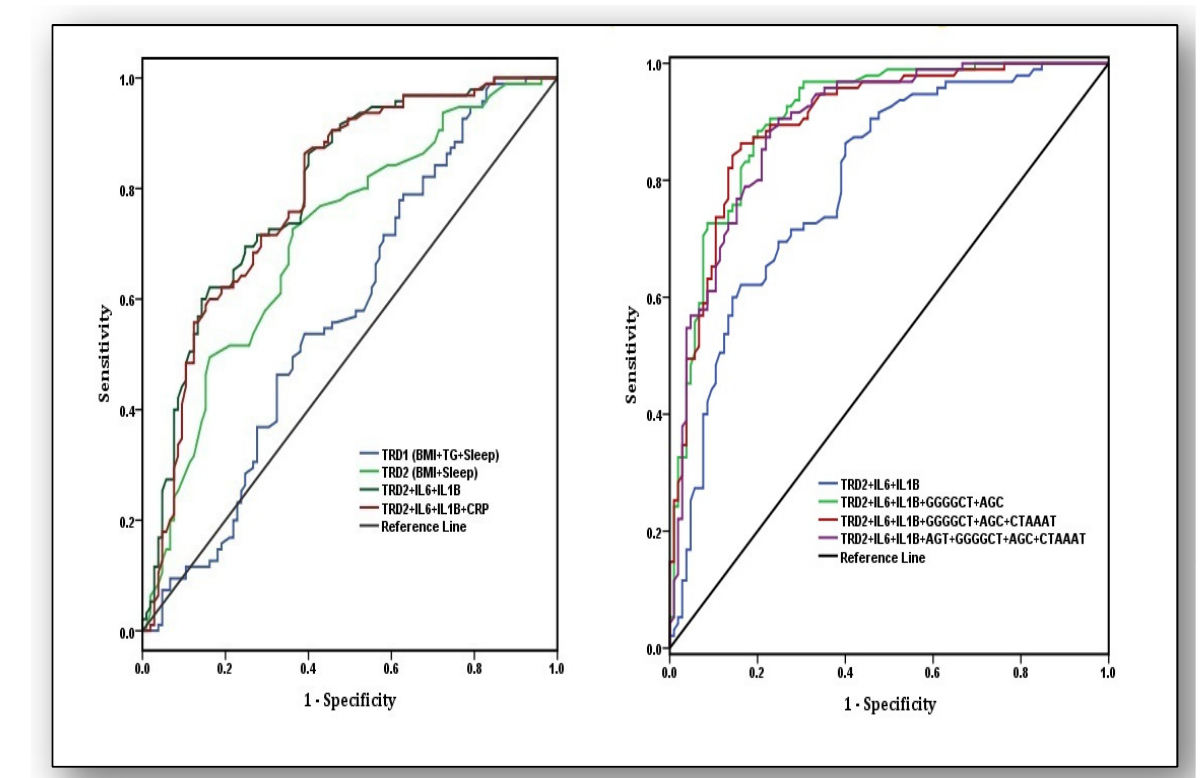
Figure 2. Areas under the receiver operating characteristic (AUROC) curves for the analysis of predictive ability of traditional risk factors (TRD1), pro-inflammatory markers, and susceptibility haplotypes for osteoarthritis risk. Traditional risk factors are body mass Index (BMI), triglycerides (TG), and sleep quality (Sleep). Pro-inflammatory markers are interleukin-6 (IL-6), interleukin 1-beta (IL-1 β ), and high sensitivity C-reactive protein(hsCRP).Haplotypes are AGT of the CRP gene, GGGGCT of the IL-6 gene, AGC of the VDR gene, and CTAAAT of the eNOS gene. In the first model, values for thearea under curve were as follows: for TRD1: BMI + TG + Sleep (AUC: 0.57 ± 0.040, 95%CI:0.49–0.65), TRD2: BMI + Sleep (AUC: 0.71 ± 0.037, 95%CI: 0.64–0.78), TRD2 + IL-6 + IL-1 β (AUC: 0.80 ± 0.031, 95%CI: 0.74–0.86), and TRD2 + IL-6 + IL-1 β + hsCRP (AUC: 0.79 ± 0.032, 95%CI: 0.72–0.85). In the second model, TRD2 + IL-6 + IL-1 β (AUC: 0.80 ± 0.031, 95%CI: 0.74–0.86), TRD2 + IL-6 + IL-1 β + GGGGCT + AGC (AUC: 0.91 ± 0.021, 95%CI: 0.87–0.95), TRD2 + IL-6 + IL-1 β + GGGGCT + AGC + CTAAAT (AUC: 0.90 ± 0.022, 95%CI: 0.86–0.94), and TRD2 + IL-6 + IL-1 β + AGT + GGGGCT + AGC + CTAAAT (AUC: 0.89 ± 0.022, 95%CI: 0.85–0.94).